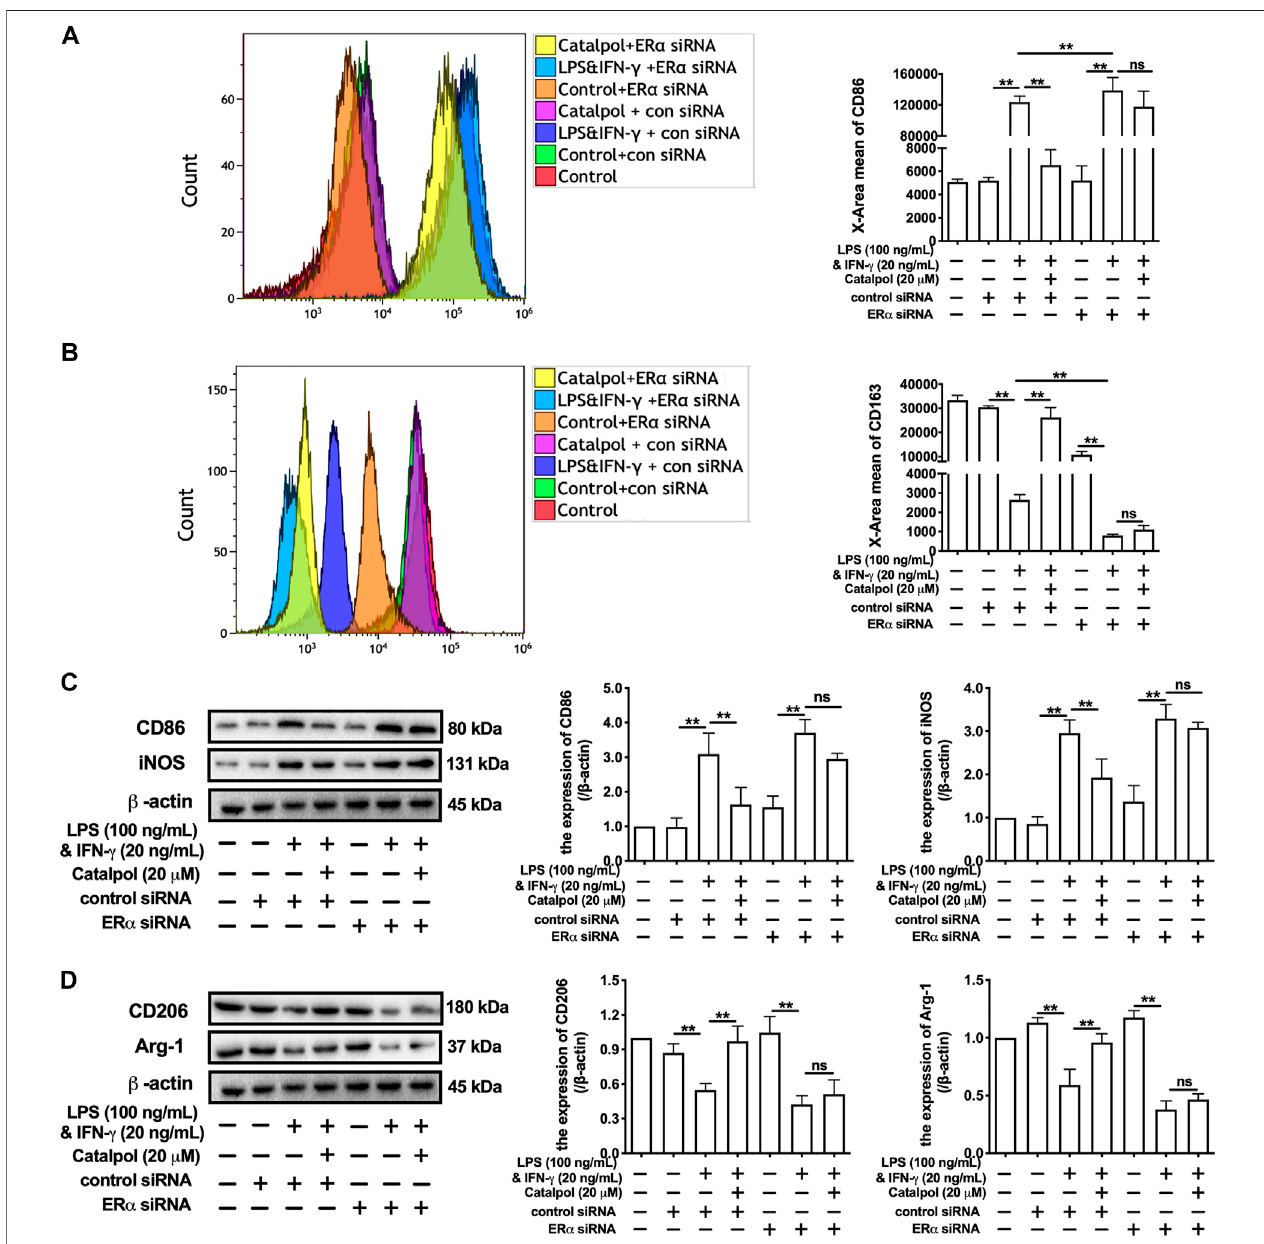
FIGURE 4 | Catalpol inhibited M1 macrophage polarization through regulating ER α . (A, B) With ER α siRNA, the level of M1 macrophage markers CD86 and M2 macrophage markers CD163 were detected by FACS ( n (cid:2) 3); (C) With ER α siRNA, effects of catalpol on the expressions of M1 macrophage markers (CD86 and iNOS) were detected by western blot ( n (cid:2) 3); (D) With ER α siRNA, effects of catalpol on the expressions of M2 macrophage markers (CD206 and Arg-1) were detected by western blot ( n (cid:2) 3). Data are expressed as mean ± SD. * p < 0.05, ** p < 0.01 vs. LPS&INF- γ